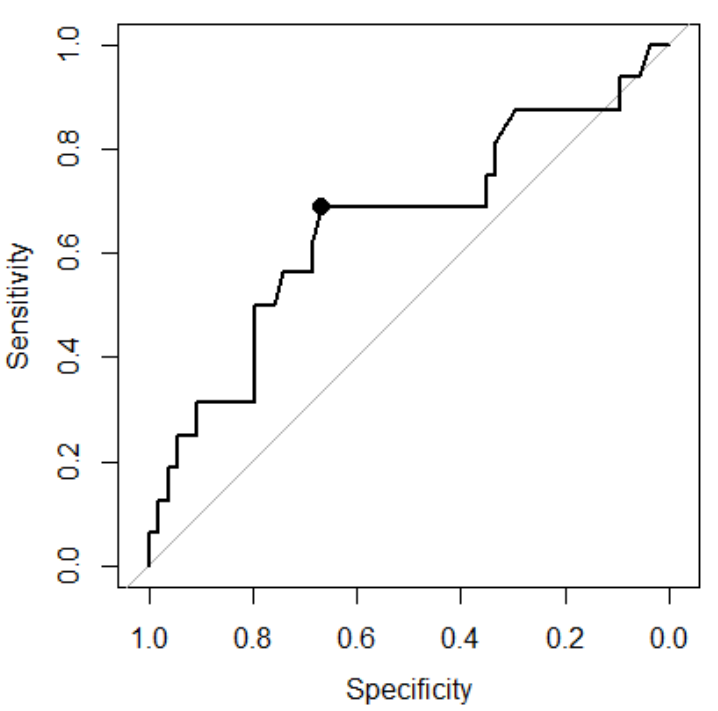
Figure 3. ROC analysis regarding post-treatment fibrinogen levels and the need for massive transfusion (AUC 0.6522). An optimal fibrinogen threshold (Youden index) of 204.5 mg · dL − 1 was determined (specificity: 0.6667, sensitivity; 0.6875).